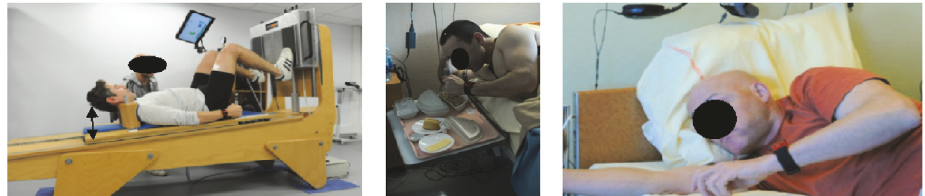
Figure 9: The posture used during head-down bed rest could explain cervical somatic dysfunction and muscle hypertrophy (Source: CNES,